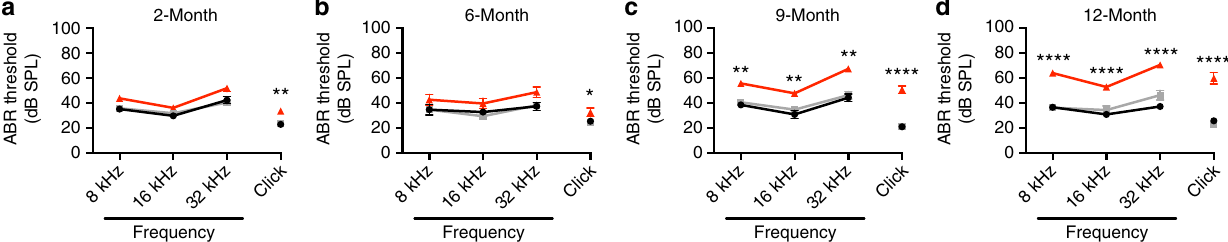
Figure 3 | ABR phenotyping of trombone mice from 2 to 12 months of age. Minimum auditory detection thresholds (decibel SPL (dB SPL)) were determined using ABR and scored independently by two operators. ( a ) At 2 months of age, Slc4a10 trmb/trmb (homozygous) mice ( n ¼ 44) show only a very mild elevation in ABR thresholds in comparison with Slc4a10 þ /trmb (heterozygous) ( n ¼ 54) and Slc4a10 þ / þ (wild-type) ( n ¼ 18) littermates. ( b ) At 6 months of age, the very mild elevation of ABR thresholds is still observed in Slc4a10 trmb/trmb mice ( n ¼ 10) compared with Slc4a10 þ /trmb ( n ¼ 21) and Slc4a10 þ / þ ( n ¼ 13) littermates. ( c ) By 9 months of age, Slc4a10 trmb/trmb mice ( n ¼ 26) show significantly elevated ABR thresholds ( B 20dB shift) across all frequencies tested compared with Slc4a10 þ /trmb ( n ¼ 25) and Slc4a10 þ / þ ( n ¼ 6) littermates. ( d ) At 12 months of age, Slc4a10 trmb/trmb mice ( n ¼ 17) continue to have elevated thresholds compared with the normal hearing Slc4a10 þ /trmb ( n ¼ 13) and Slc4a10 þ / þ ( n ¼ 7) control mice. In addition, the average hearing thresholds of Slc4a10 trmb/trmb mice increase between 9 and 12 months of age. The Slc4a10 þ /trmb and Slc4a10 þ / þ control mice do not show any auditory decline during the first 12 months of life, nor do they show any significant differences between their auditory thresholds at any frequency or age tested. Black circle/line, Slc4a10 þ / þ ; grey square/line, Slc4a10 þ /trmb ; red triangle/line, Slc4a10 trmb/trmb . Data shown are mean ± s.e.m. and significance determined using a one-way ANOVA with Tukey’s multiple comparisons test comparing Slc4a10 trmb/trmb threshold data with the